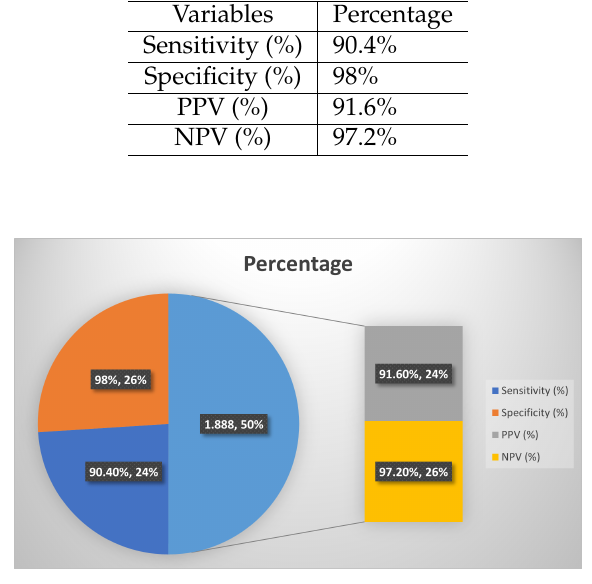
Figure 3. Graphic representation of the effect of ICT Solutions on total anthropogepainic GHG